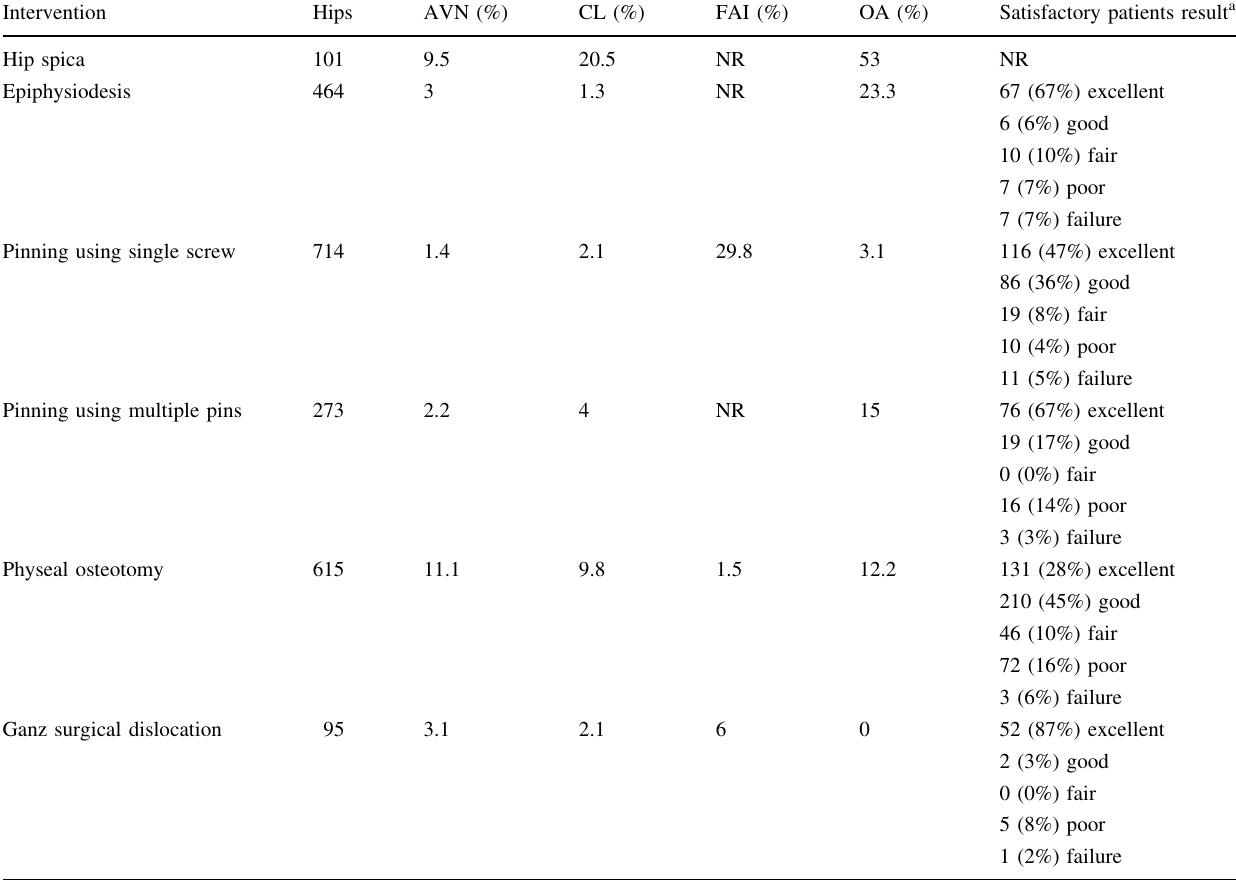
Table 3 Pooled summary of studies of stable slip treatments